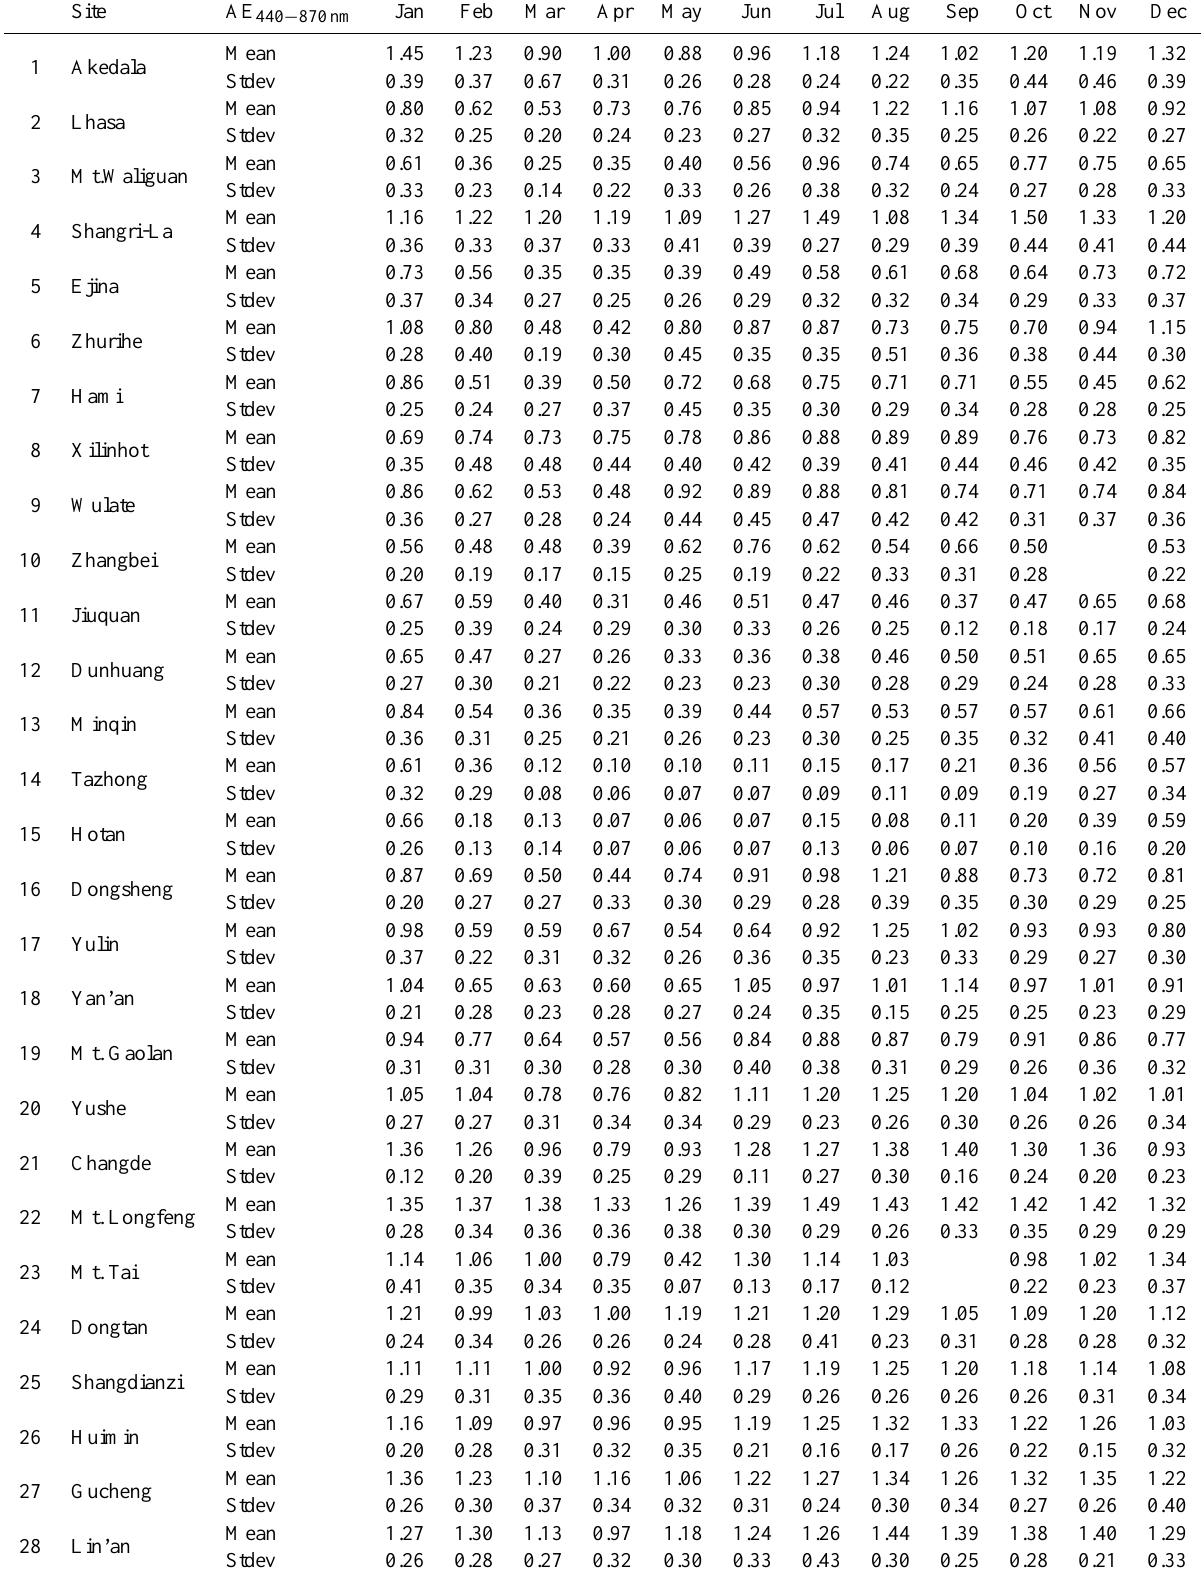
Table A4. Data of Figs. 6–15: AE between 440 and